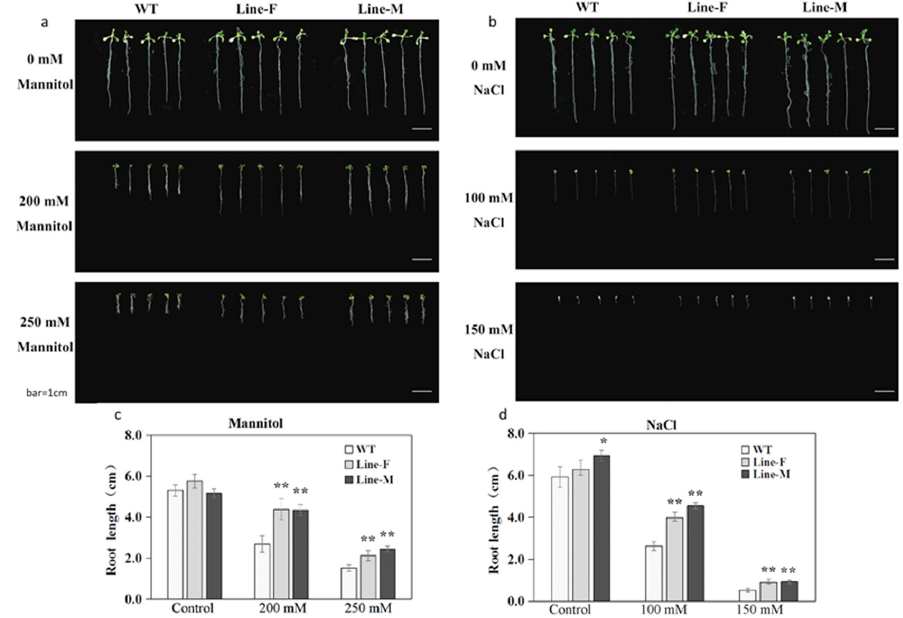
Figure 3. Growth of MfWRKY17 overexpression seedlings under stress treatment. ( a , b ) showed morphology of seedlings of wild-type (WT) and transgenic lines growing on media, supplied with di ff erent concentrations of mannitol and NaCl, respectively. ( c , d ) indicated the measured root length of seedlings treated with mannitol and NaCl, respectively. Asterisks indicated significant di ff erence (* p < 0.05, ** p < 0.01, by independent sample T-test) compared to WT.